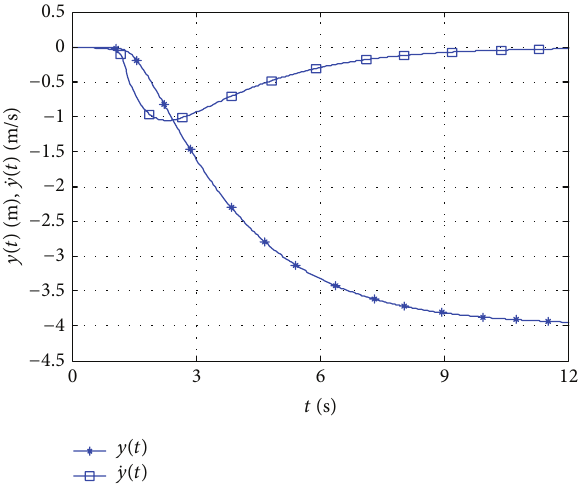
Figure 7: Surge motions of the tensegrity-based water wave energy harvester.